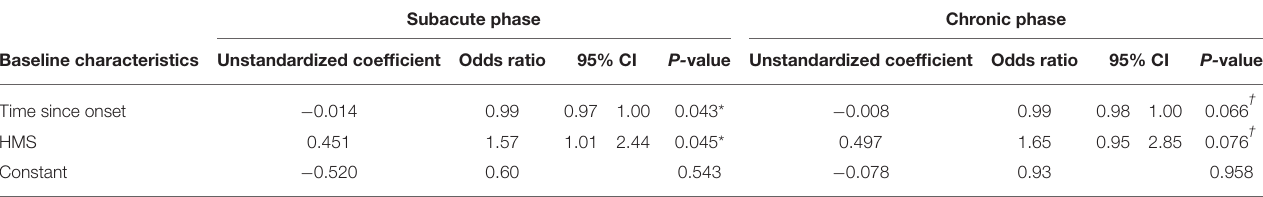
TABLE 2 | Multivariable analyses using the MCID of the FMA-UE as the outcome measure according to stroke phase. Subacute phase Chronic